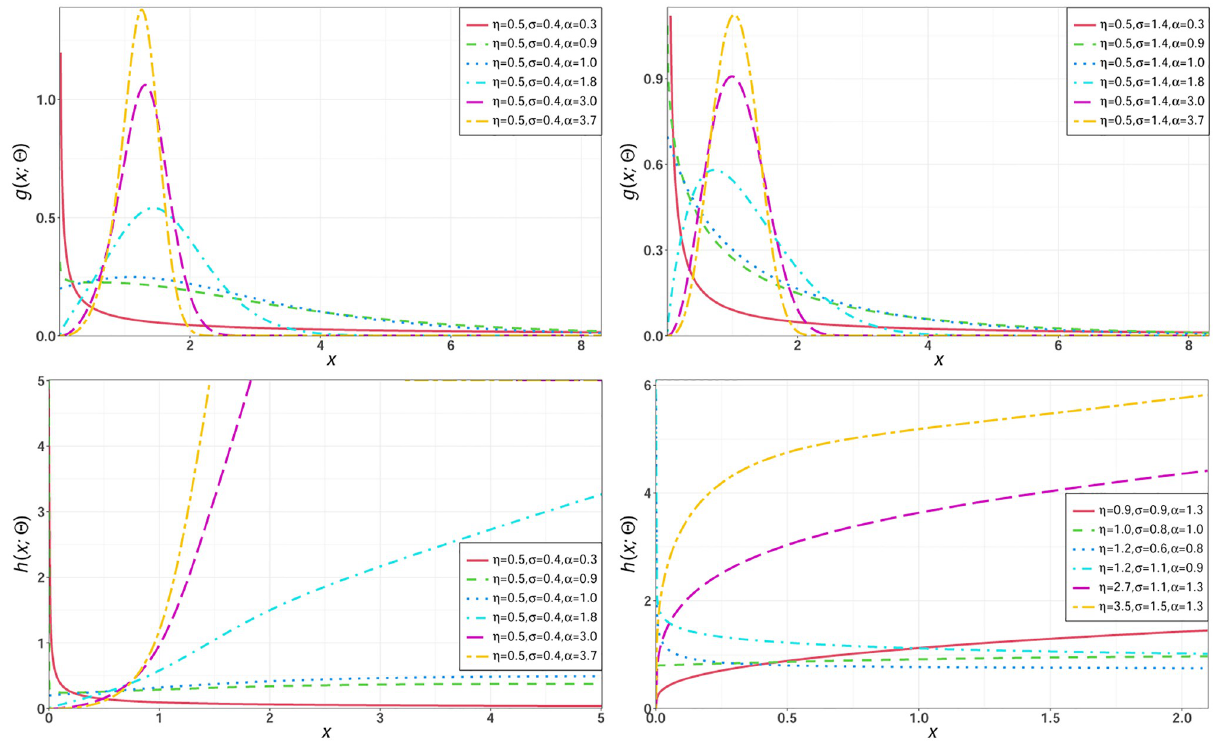
Fig 1. Different shapes for the pdf and hrf of the NEHTW